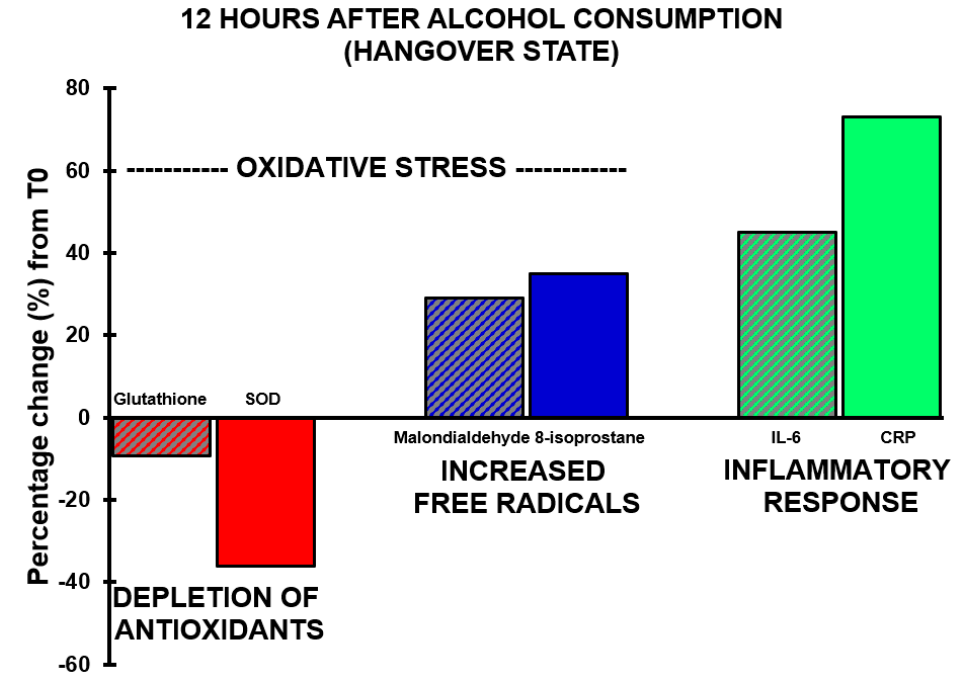
Figure 3. Oxidative stress and the inflammatory response during alcohol hangover. Percentage changes between assessments made 12 h after alcohol consumption relative to T0 (the assessment made before alcohol consumption) are shown. Abbreviations: CRP = C-reactive protein, IL-6 = interleukin-6, SOD = superoxide dismutase.